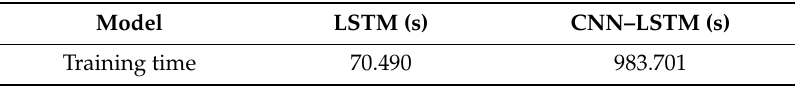
Table 11. Performance of LSTM vs. CNN–LSTM.